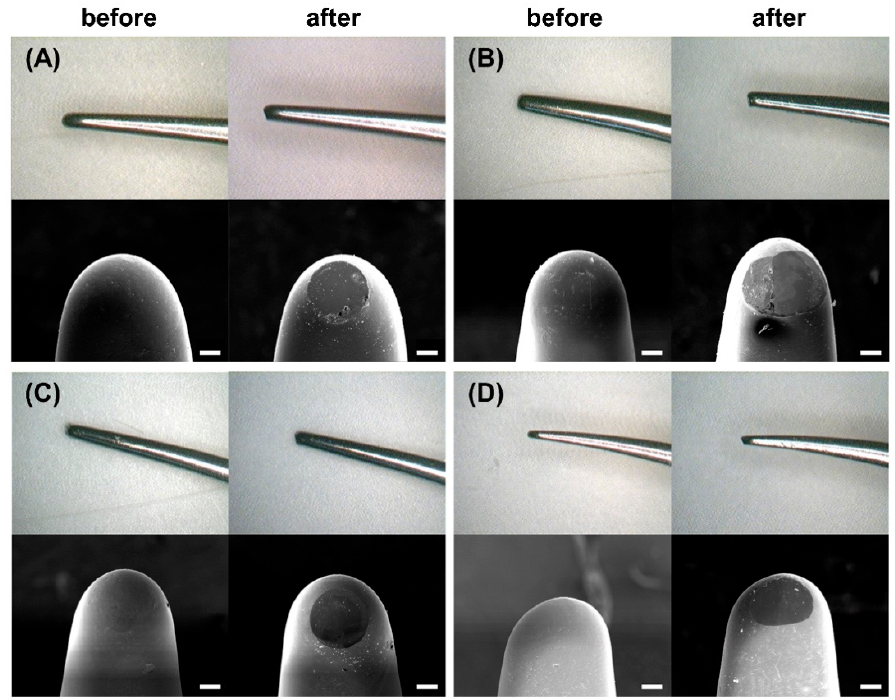
Figure 8. Representative images analyzer (upper row) and SEM images (lower row) obtained for each group of surfaces before and after the wear test: ( A ) EM, ( B ) AM, ( C ), DM and ( D ) OM. Scale bar is 1 μ m. Table 2. Comparison of wear degree by mass for each group.